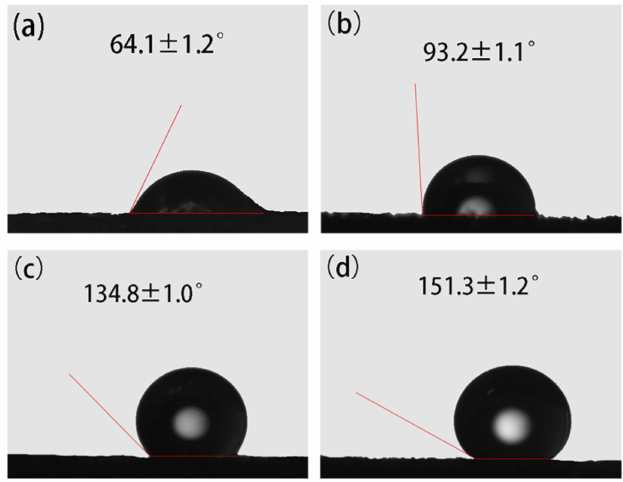
Figure 2. Water contact angles (WCAs) of various coupling agent-CNTs/PU sponges: ( a ) pre-treated PU sponge, ( b ) octadecyldimethyltrimethoxysilylpropylammonium chloride-CNTs/PU sponge, ( c ) hexadecyltrimethoxysilane-CNTs/PU sponge, and ( d ) Octadecyltrichlorosilane (OTS)-CNTs/PU sponge (experimental conditions: pH = 7, coupling time = 24 h at 25 ◦ C).